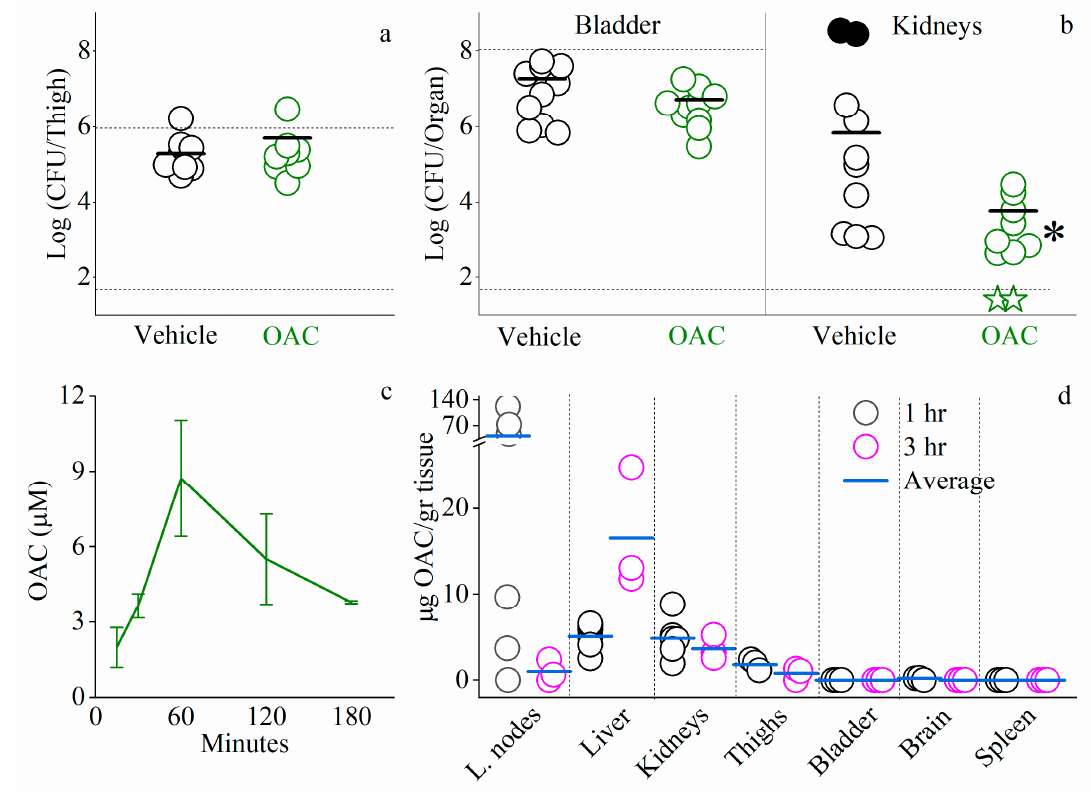
Figure 10. Systemic efficacy studies using mouse infection models. ( a , b ) Data points represent colony forming unit (CFU) counts harvested from infected mice (8 and 10 mice per group, respectively). Panel ( a ) depicts results of the thigh infection model where mice were inoculated intramuscularly with E. coli 25922 (upper dashed line represents the inoculum) and treated subcutaneously with C 14( ω 5) OOc 10 O (12.5 mg/kg) at 1 and 3 h post-infection. Panel ( b ) depicts results of the urinary tract infection model where mice were infected with E. coli UPEC CFT073 by intra-urethral injection and treated subcutaneously with C 14( ω 5) OOc 10 O (12.5 mg/kg) at 1 and 6 h post-infection. Solid circles denote mice that died before the experimental endpoint. Green stars denote lack of detectable CFU. Horizontal bars specify the average. The juxtaposed asterisk (*) denotes statistically significant difference ( p -value = 0.003 or 0.008, if the dead mice are not included). The limit of detection is represented by the lower dashed line (log 10 50 CFU/mL = 1.69). Panels ( c , d ) show the evolution of C 14( ω 5) OOc 10 O concentrations in mouse plasma ( c ) or in organs ( d ) after single subcutaneous administration (12.5 mg/kg) to ICR mice (data in c are from two mice/time points except for 60 and 180 that were 8 and 3, respectively) as determined by liquid chromatography–mass spectrometry. Error bars represent standard deviations. The limit of detection was 0.5 ppm (0.68 μ M).